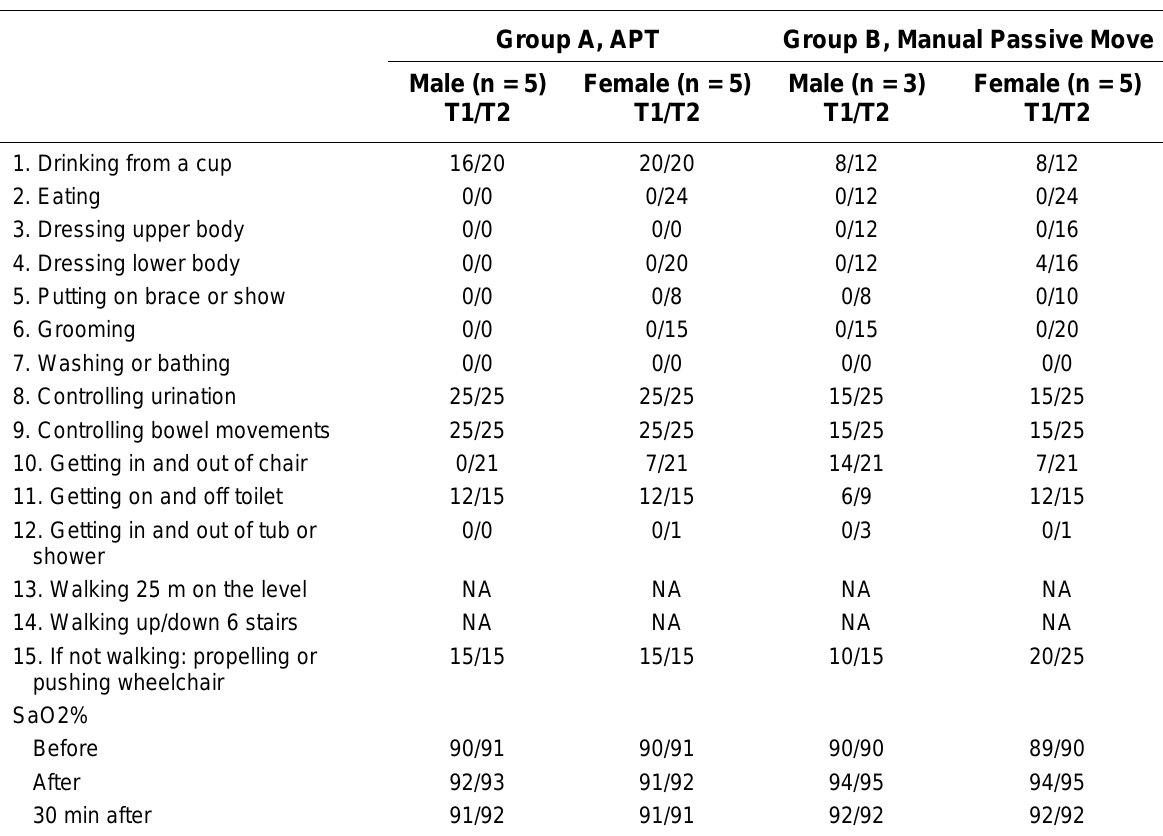
BI Scores and SpO2%